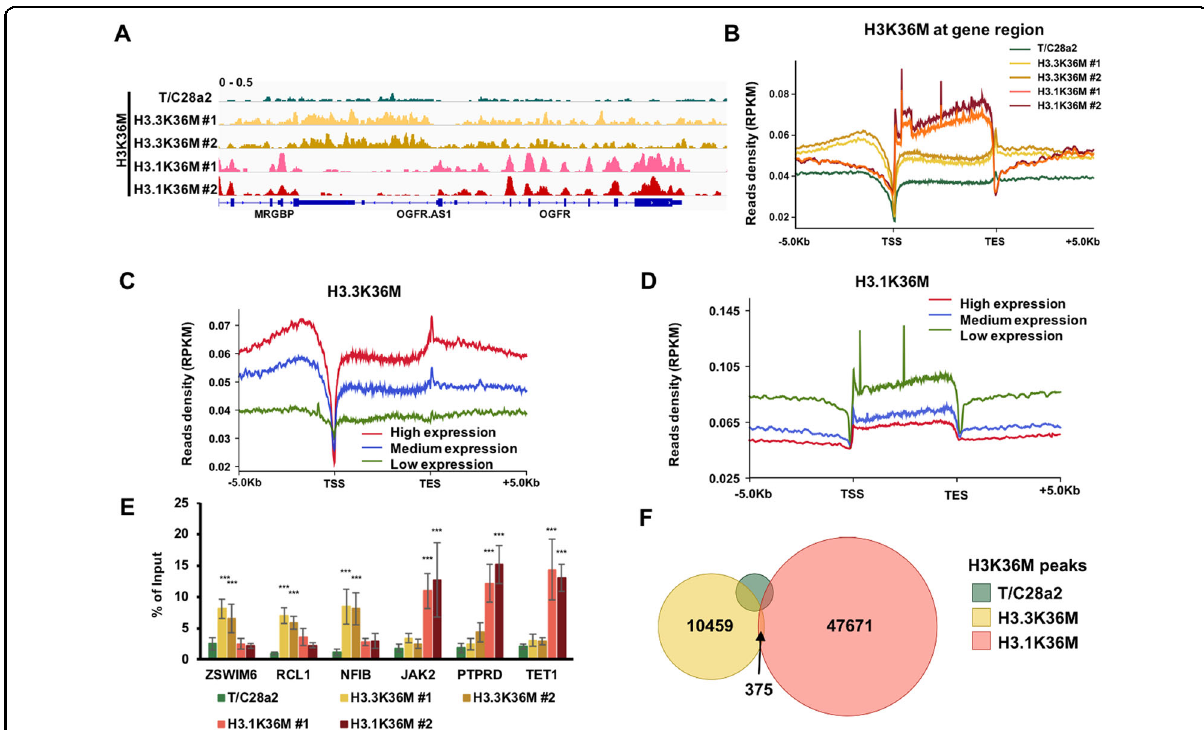
Fig. 5 H3.3K36M is enriched in regions lacking H3.1K36M. A IGV tracks showing the chromatin distributions of H3K36M in wild-type (WT), H3.3K36M-, and H3.1K36M-mutant cell lines. B The distribution pro fi les of normalized H3K36M read density from 5 kb upstream of the TSS to 5 kb downstream of the TES. PRKM reads per kilobase million. C , D Normalized read density of H3K36M from 5 kb upstream of the TSS to 5 kb downstream of the TES in grouped genes with high, medium, and low expression levels. The average read densities of the H3K36M ChIP-seq in H3.3K36M- ( C ) and H3.1K36M- ( D ) mutant cells were calculated. The genes were separated into high expression, medium expression, and low expression groups based on their expression levels. E H3K36M enrichment analyzed via ChIP-qPCR. The data are represented by the mean ± SD ( N = 3 independent replicates, *** p < 0.001). F Venn diagram illustrating the overlap of the H3K36M peaks in H3.3K36M- and H3.1K36M-mutant cells. The H3K36M peaks in independent H3.3K36M- and H3.1K36M-mutant clones were